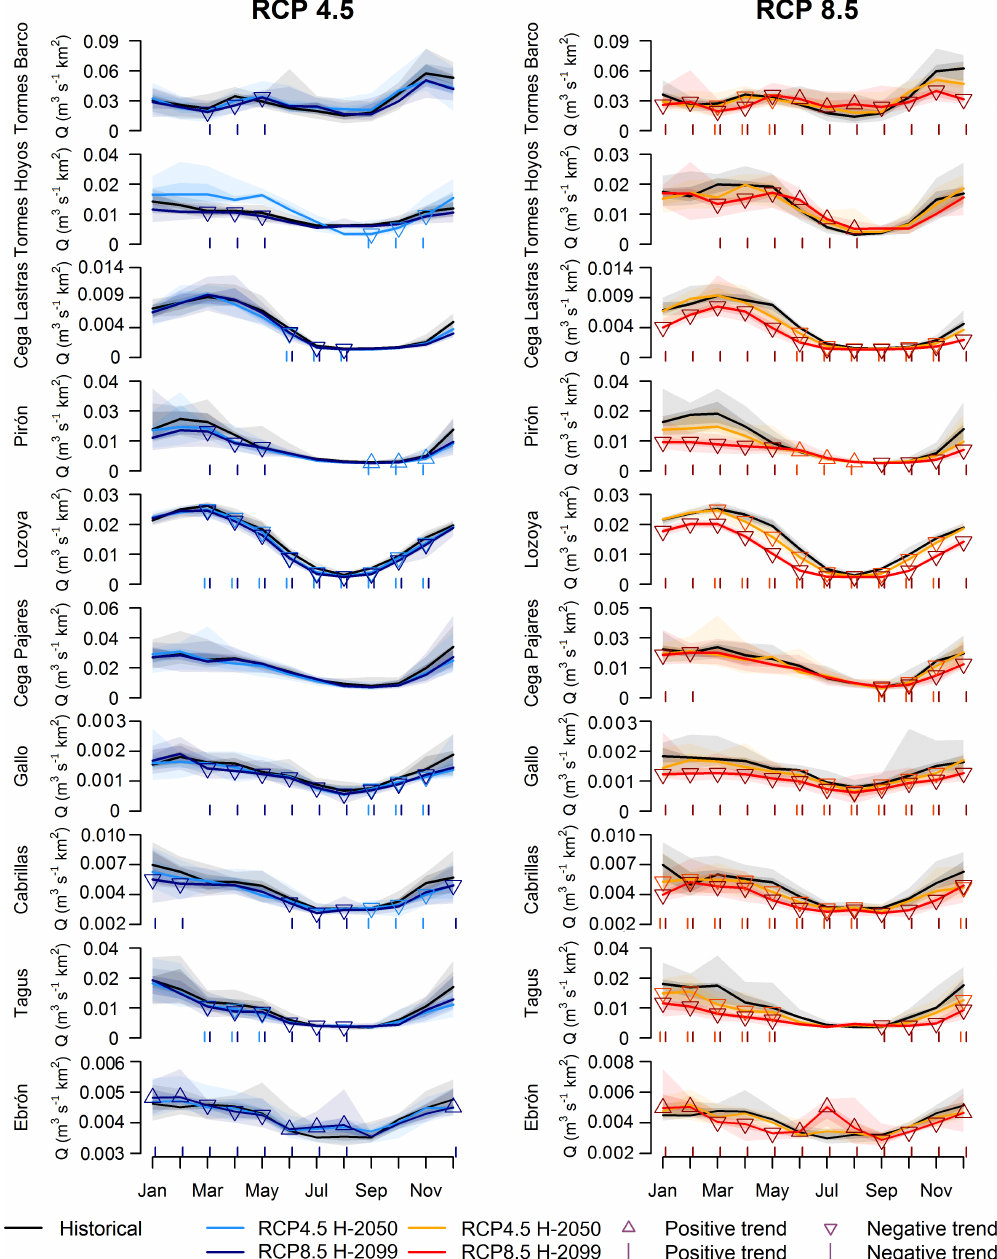
Figure 5. Predicted monthly mean specific flow in H-2050 and H-2099 for the RCP4.5 and RCP8.5 scenarios. Shaded areas indicate decadal fluctuations. Triangles show significant negative or positive trends (Sen’s slope p ≤ 0.05); the sign of each trend is indicated by the directions in which the triangles